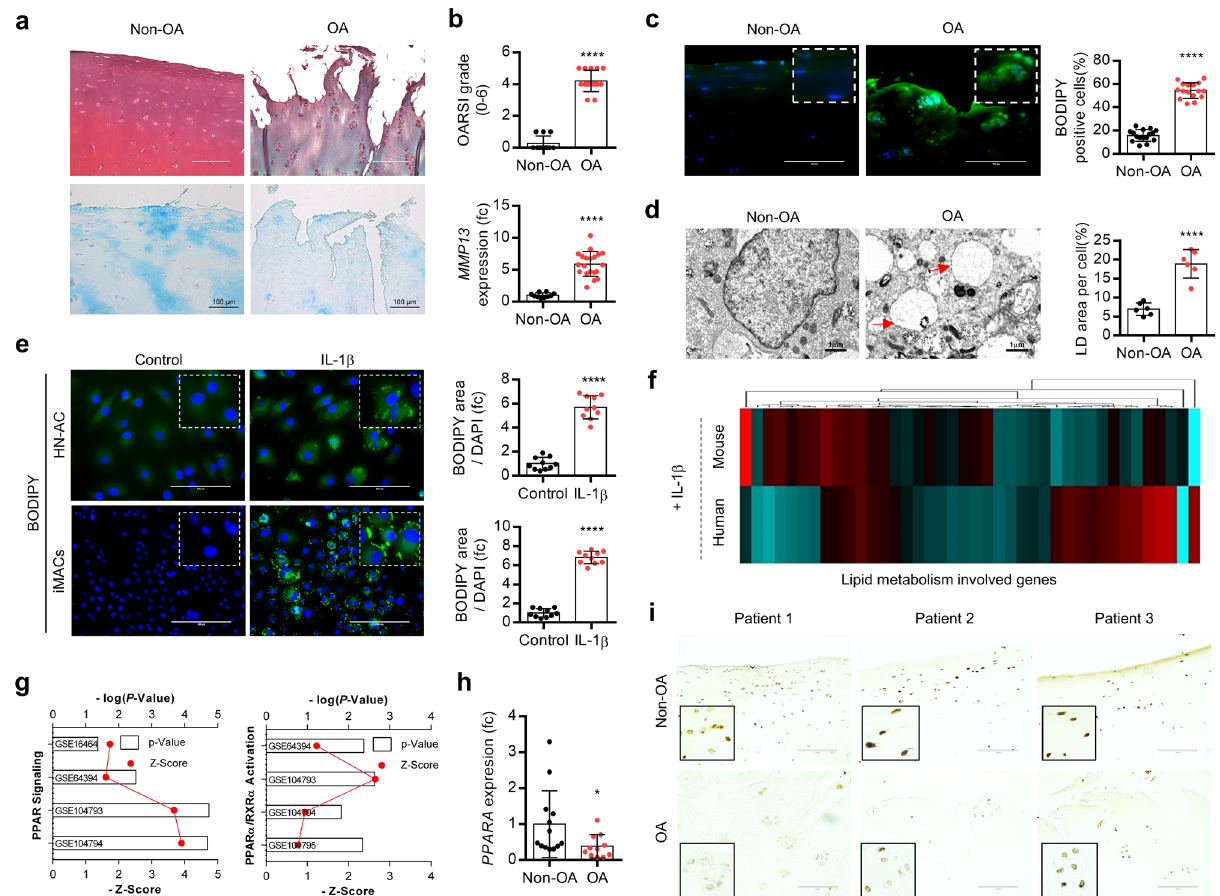
Fig. 1 PPAR α is responsible for lipid deposition (LD) during OA pathogenesis. a Safranin O and Alcian blue staining in non-OA and OA cartilages(non- OA, n = 11; OA, n = 15). Scale bar, 100 μ m. b The degree of cartilage degradation is quanti fi ed according to OARSI grade. MMP13 mRNA transcription level in non-OA and OA chondrocytes (non-OA, n = 10; OA, n = 19), P < 0.0001. c LD is stained by BODPY (green) in intact cartilage isolated from patients (non-OA, n = 16) and damaged region (OA, n = 20). Scale bar, 200 μ m. P < 0.0001. d Transmission electron micrographs of non-OA ( n = 6) and OA